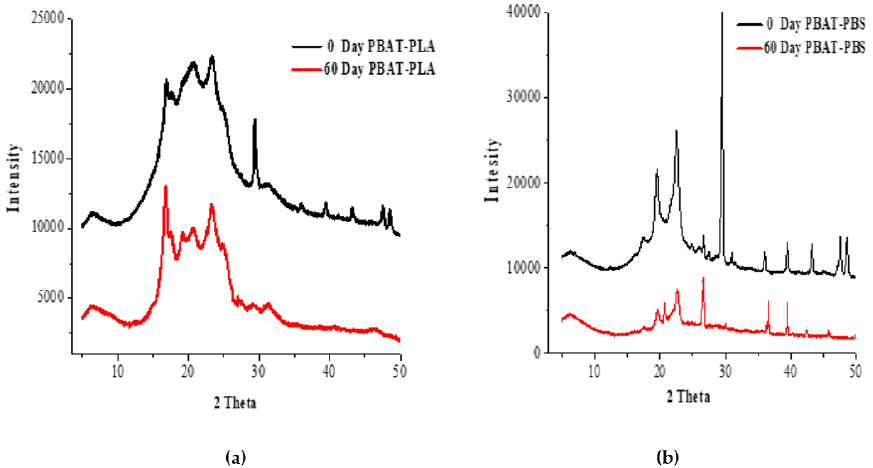
Figure 5. ( a ) XRD curves of the PBAT–PLA blend before and after degradation, and ( b ) XRD curves of the PBAT–PBS blend before and after degradation.